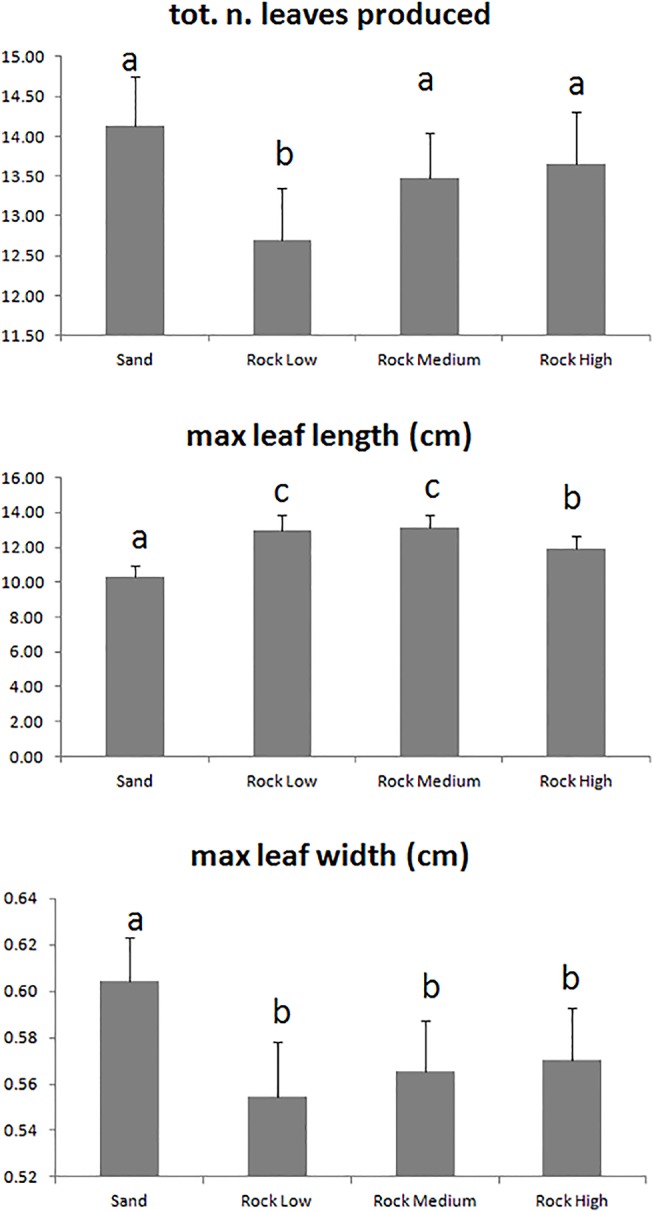
Effect of the Substrate on morphological variables of P. oceanica seedlings.Mean values + standard errors are shown only for those variables for which a significant effect of the factor Substrate was detected. Letters above standard error bars indicate significant differences between treatment levels.